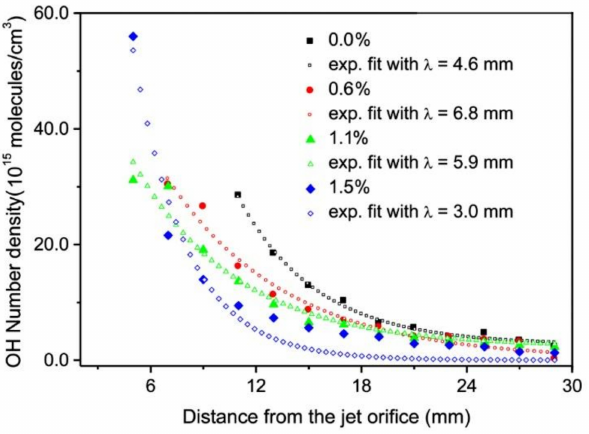
Figure 8. Decay length of the density of OH radicals in Ar plasma with various H 2 O contents from 0 to 1.5%. Reprinted with permission from [27] (Srivastava et al.). Copyright 2021 American Institute of